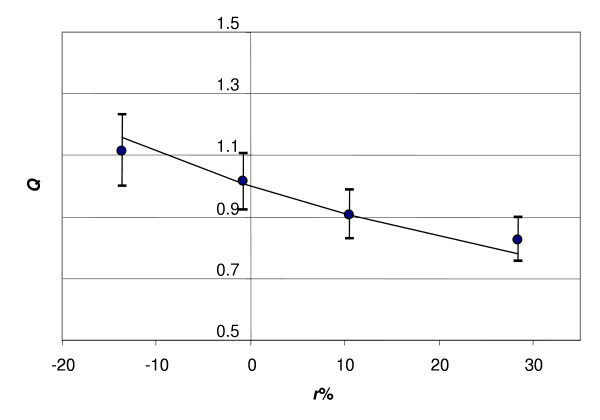
Correlation between Q and redundant body mass (r%). Solid line is equation (1.8); dots are average values of Q (1.9) with a least squares fit to (1.8) yielding q = 0.233. Each point presents the average value calculated from 15 observations. Error bars represent 95% confidence intervals.